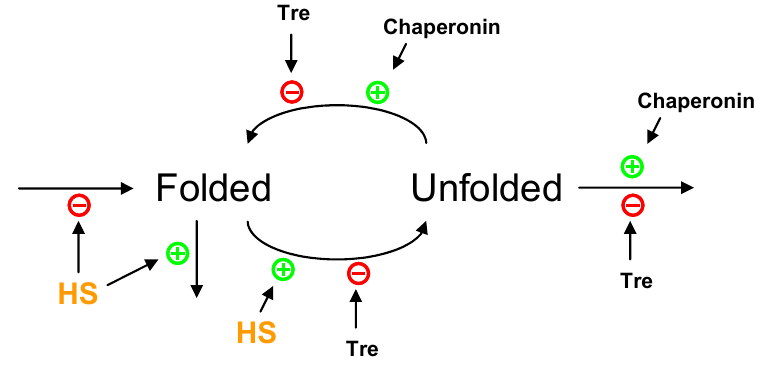
Figure 3. Scheme of the competing forces affecting protein folding and unfolding. Heat stress (HS) causes the unfolding of proteins, while chaperonins promote their refolding. Trehalose functions as a protein stabilizer preventing denaturation and aggregation; however, it also interferes with the proper functioning of heat shock proteins (here represented by Chaperonin) in the refolding of denatured